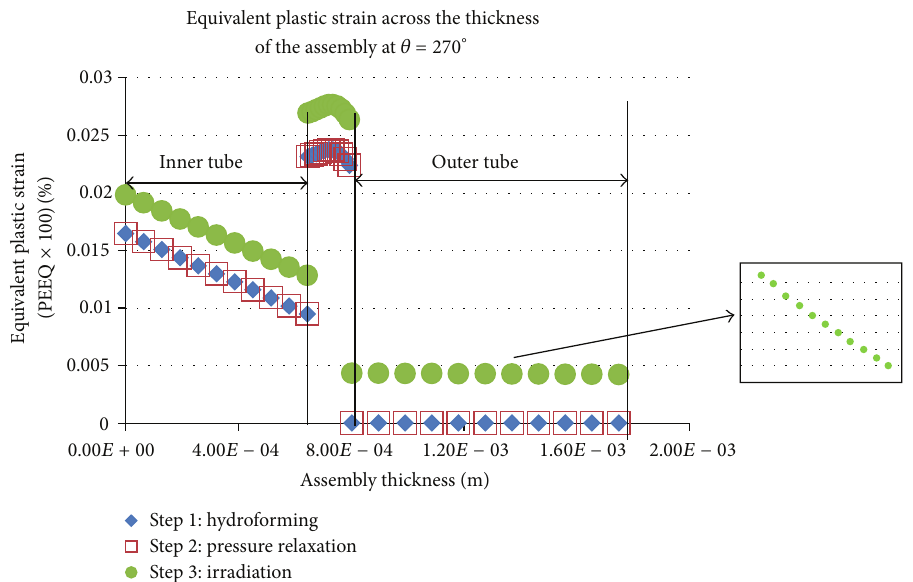
Figure 9: Equivalent plastic strain across the assembly radius at 𝜃 = 270 ∘